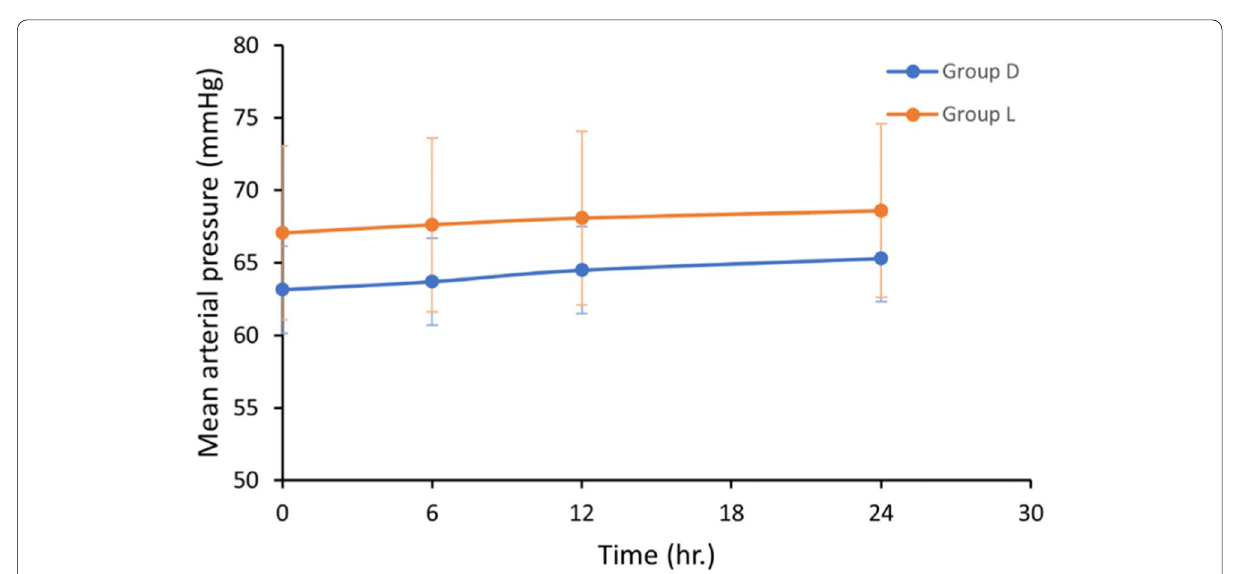
Fig. 4 Post-operative mean arterial pressure for the two